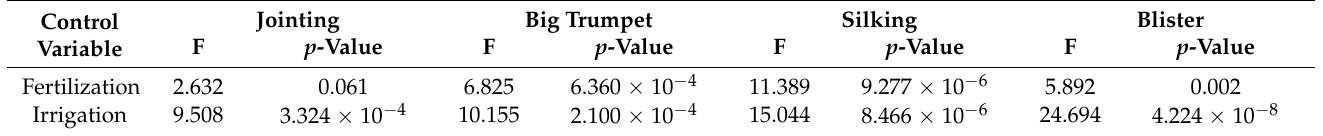
Table 4. ANOVA results between LAI and control variables in